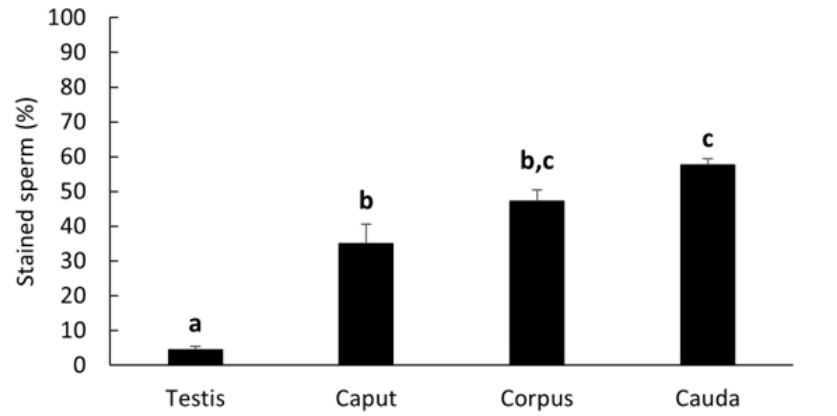
Figure 6. Percentages (mean ± SEM) of spermatozoa stained for LGALS3BP in the centrosome region from testicular tissue and each epididymal segment (n = 5 males). Bars with different letters significantly differ ( p ≤ 0.001).